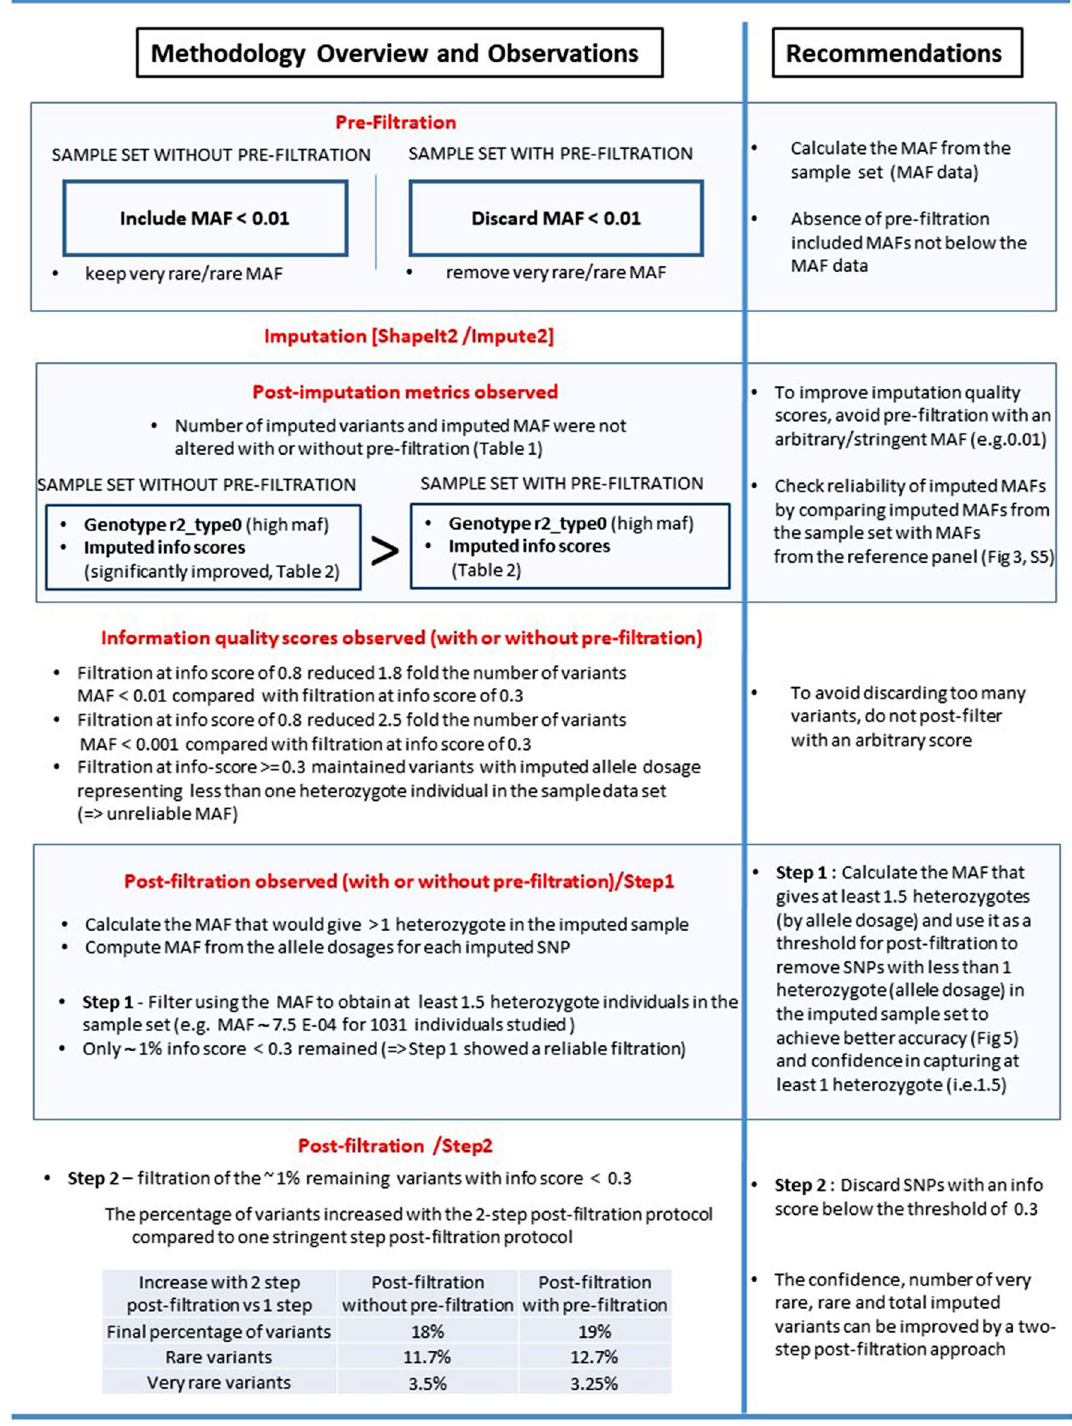
Figure 6. Methodology overview. After imputation a significant amount of variants are discarded by current practices. Some of these variants may provide important insight for determining disease risk. Here we investigate the effect of filtration strategies on the profiles of imputed variants and provide recommendation to improve the imputation quality and to reduce the amount of variants